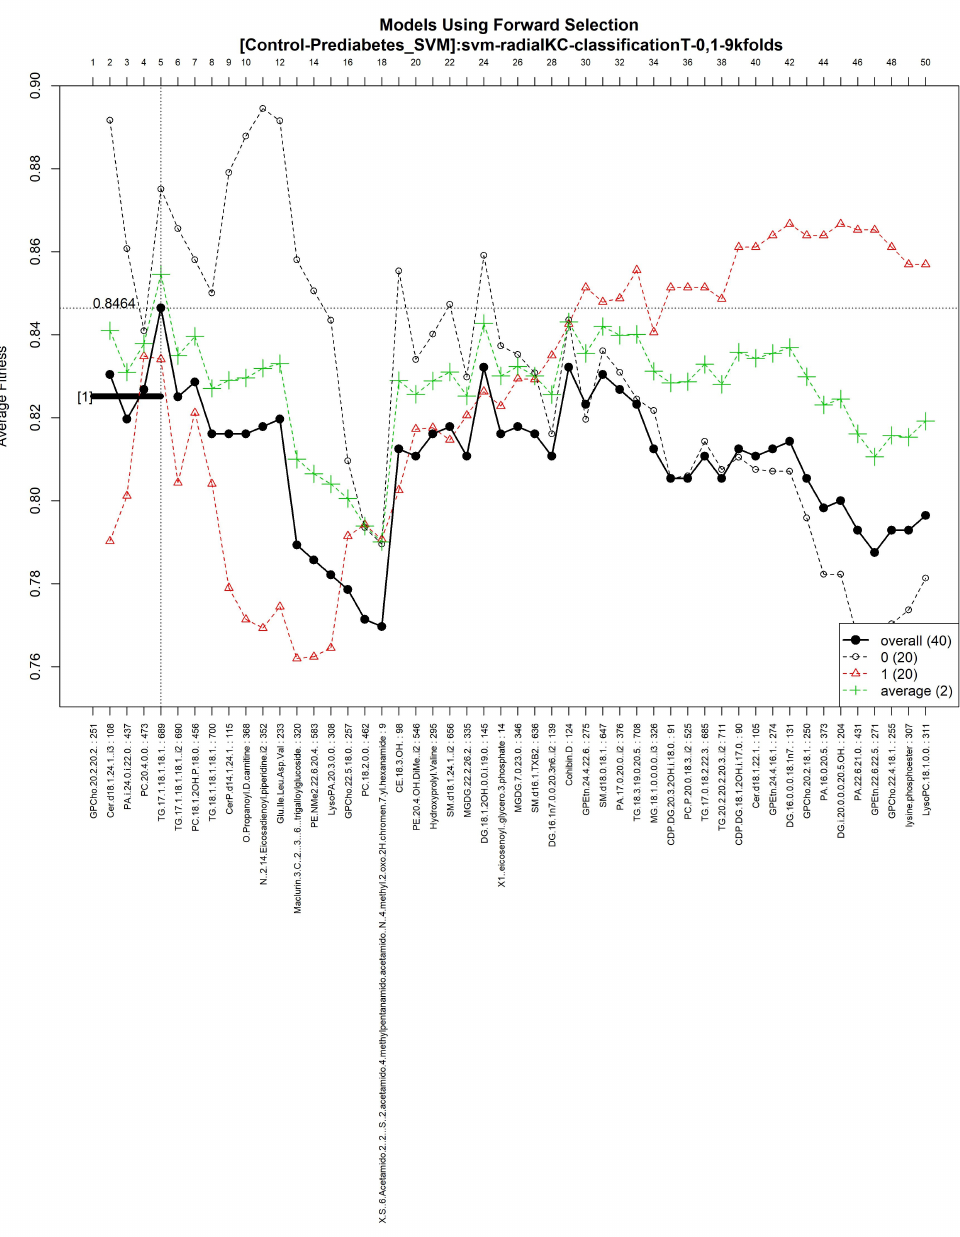
Figure 2. Models using forward selection methodology, with the Control-Prediabetes dataset. The solid black line represents the most compact and accurate model. The vertical axis shows the classifi- cation’s accuracy. The horizontal axis represents the ordered features, each of which corresponds to a number and a specific